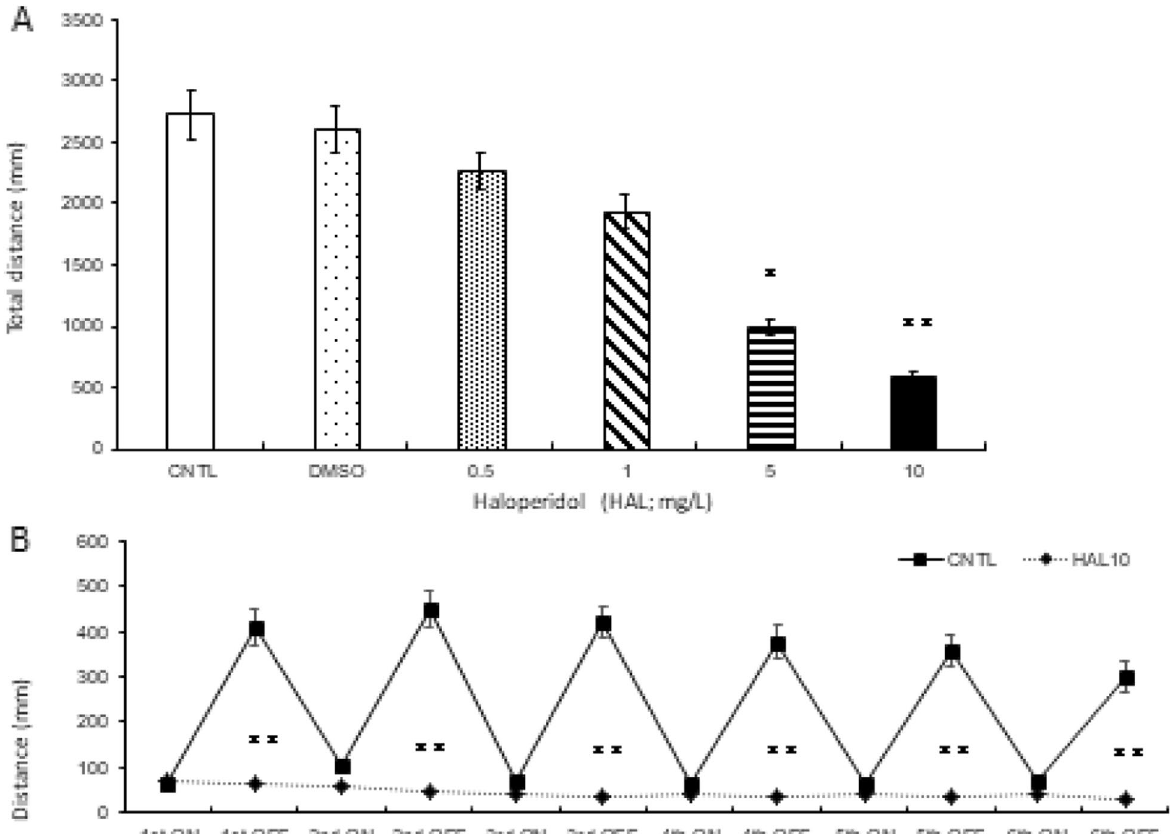
Fig. 1. HAL-induced Parkinsonism zebrafish model. Comparison between the CNTL and HAL-treated groups at different doses (0.5, 1, 5, 10 mg/L). HAL at 10 mg/L exerted the strongest significant decrease in movement compared with the CNTL ( a ). The light (ON) /dark (OFF) -stimulation response of the HAL 10 mg/L-treated group was significantly reduced during all dark conditions (first to sixth) compared to that of the CNTL ( b ). CNTL: Control, DMSO: dimethyl sulfoxide 0.05%, HAL10: Haloperidol 10 mg/L, ON: light-on period, OFF: light-off period. Tukey-Kramer test; * p < 0.05, ** p <0.01. All values are presented as means standard errors of the mean (SEMs) of at least three independent experiments ( n ± =